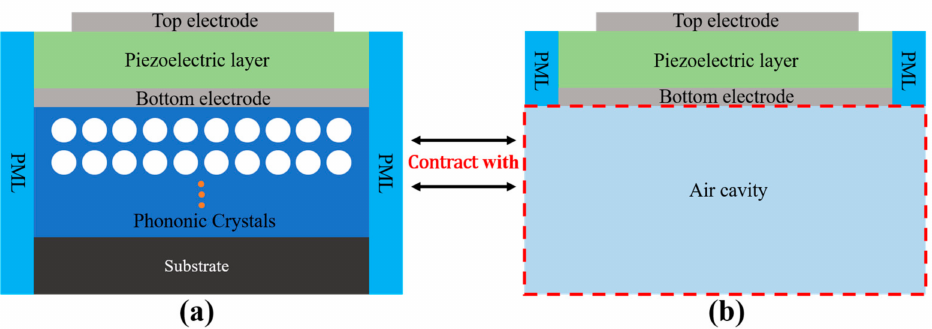
Figure 8. Two-dimensional structure of a bulk acoustic wave resonator with a PhC structure ( a ). Traditional FBAR with the air cavity, used for modeling ( b ).